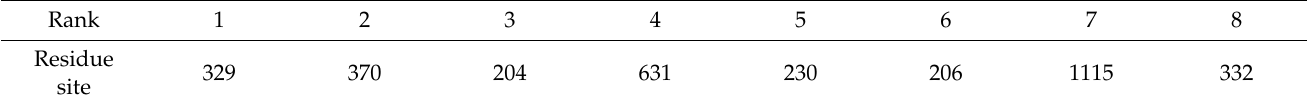
Table 2. Top eight sites with the largest average absolute values of